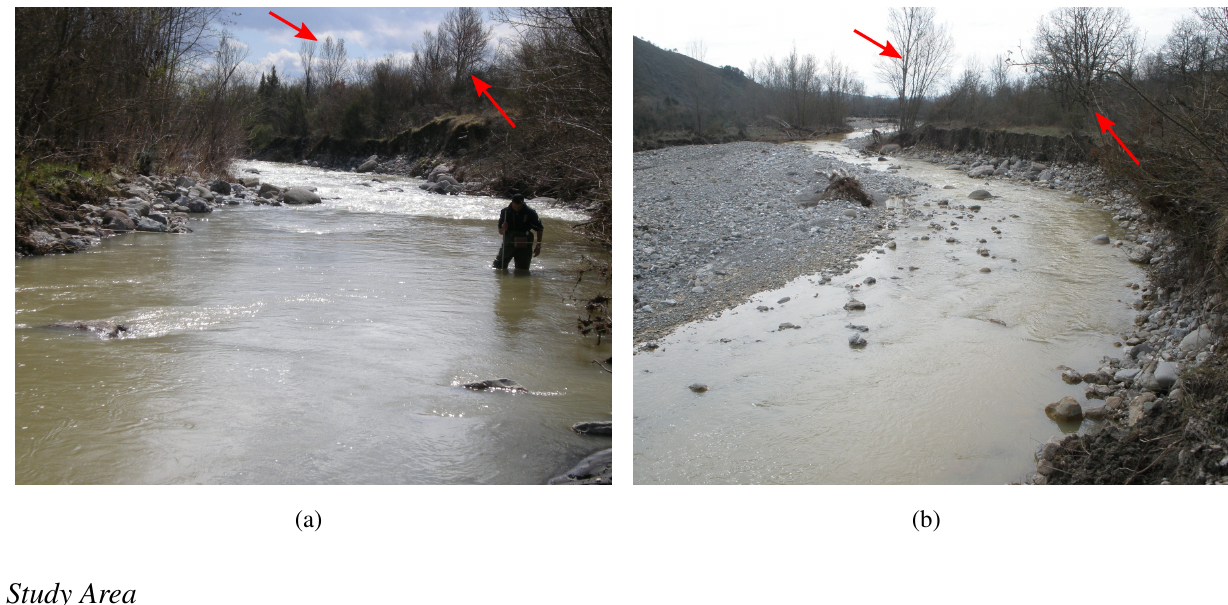
Figure 3. Comparison of the channel morphology of the Paglia River before and after the flood event of November 2012. ( a ) represents the pre-flood state (September 2012), while ( b ) shows the post-flood set-up (March–May 2013). Pictures refer to the PC01 sampling point (collocation in Figure 4). The trees indicated by the red arrows may be employed as reference spatial